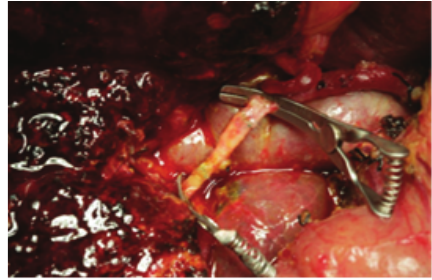
Figure 4: The right hepatic artery after bridging